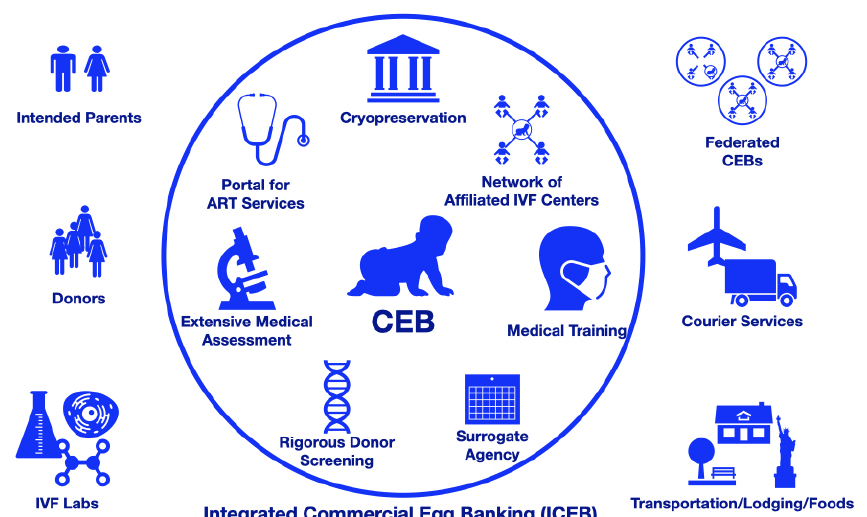
Figure 1. The landscape of an